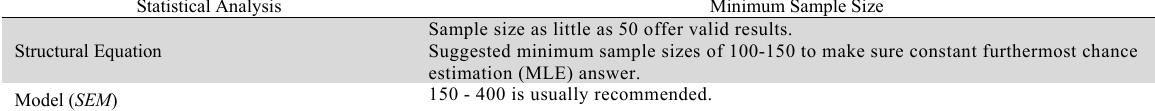
Statistical Techniques with Minimum Sample Size Requirements (Hair et al., 2006) Statistical Analysis Minimum Sample Size Structural Equation